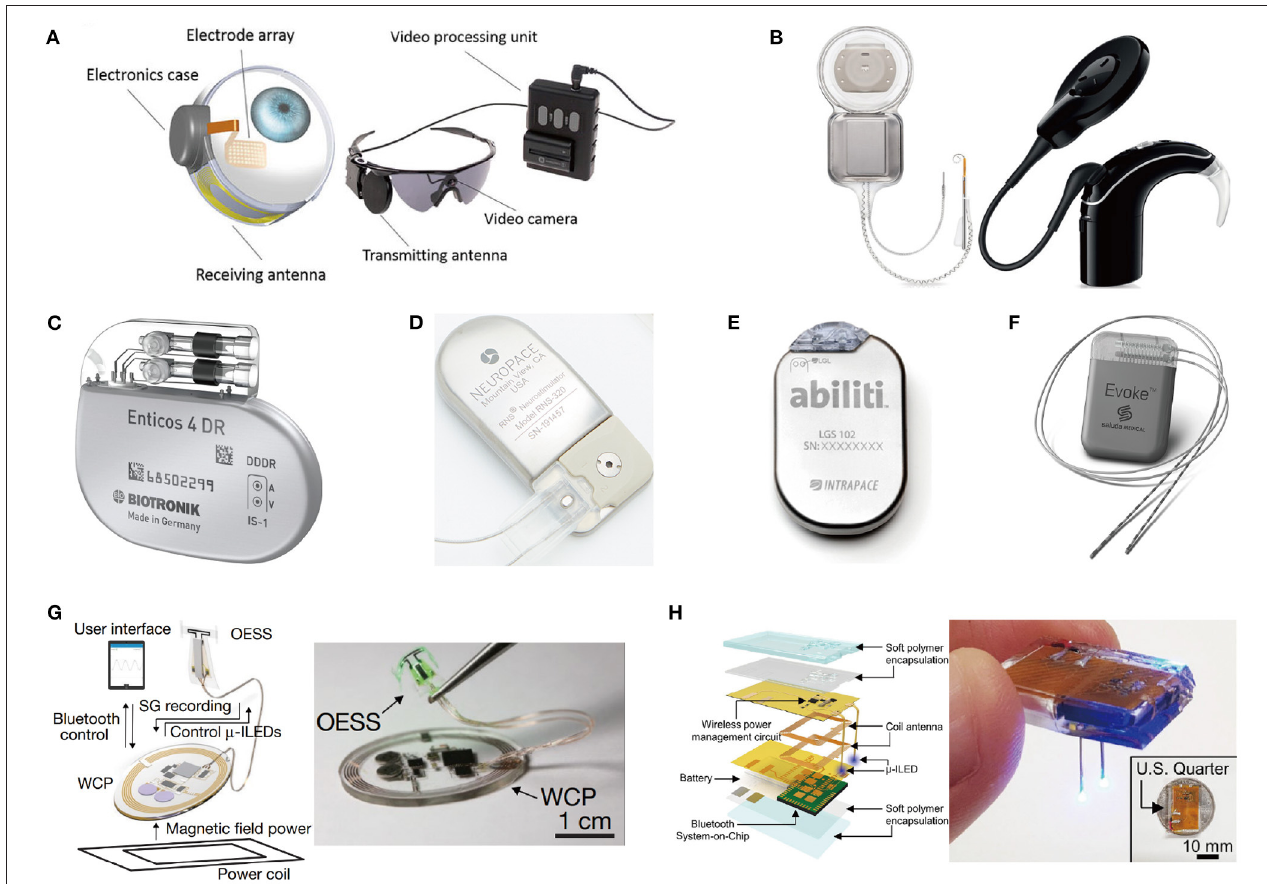
FIGURE 2 | State of the art implant neural stimulation systems: (A) Argus II Retinal prosthesis implant operate (Farvardin et al., 2018); (B) Cochlear Contour TM cochlear implant system ( Parkinson et al., 2002); (C) Closed-loop pacemaker of Biotronik (Biotronik, aker); (D) Responsive neurostimulator (RNS) system of NeuroPace ( Sun et al., 2008); (E) Abiliti closed-loop gastric stimulator (Horbach et al., 2015); (F) Evoke closed-loop spinal cord stimulation system (Russo et al., 2018 ); (G) Wireless optical peripheral stimulation system for bladder control (Mickle et al., 2019); (H) Fully chip-type implanted optical DBS system through the combination of wireless rechargeable battery and stimulator (Kim et al.,